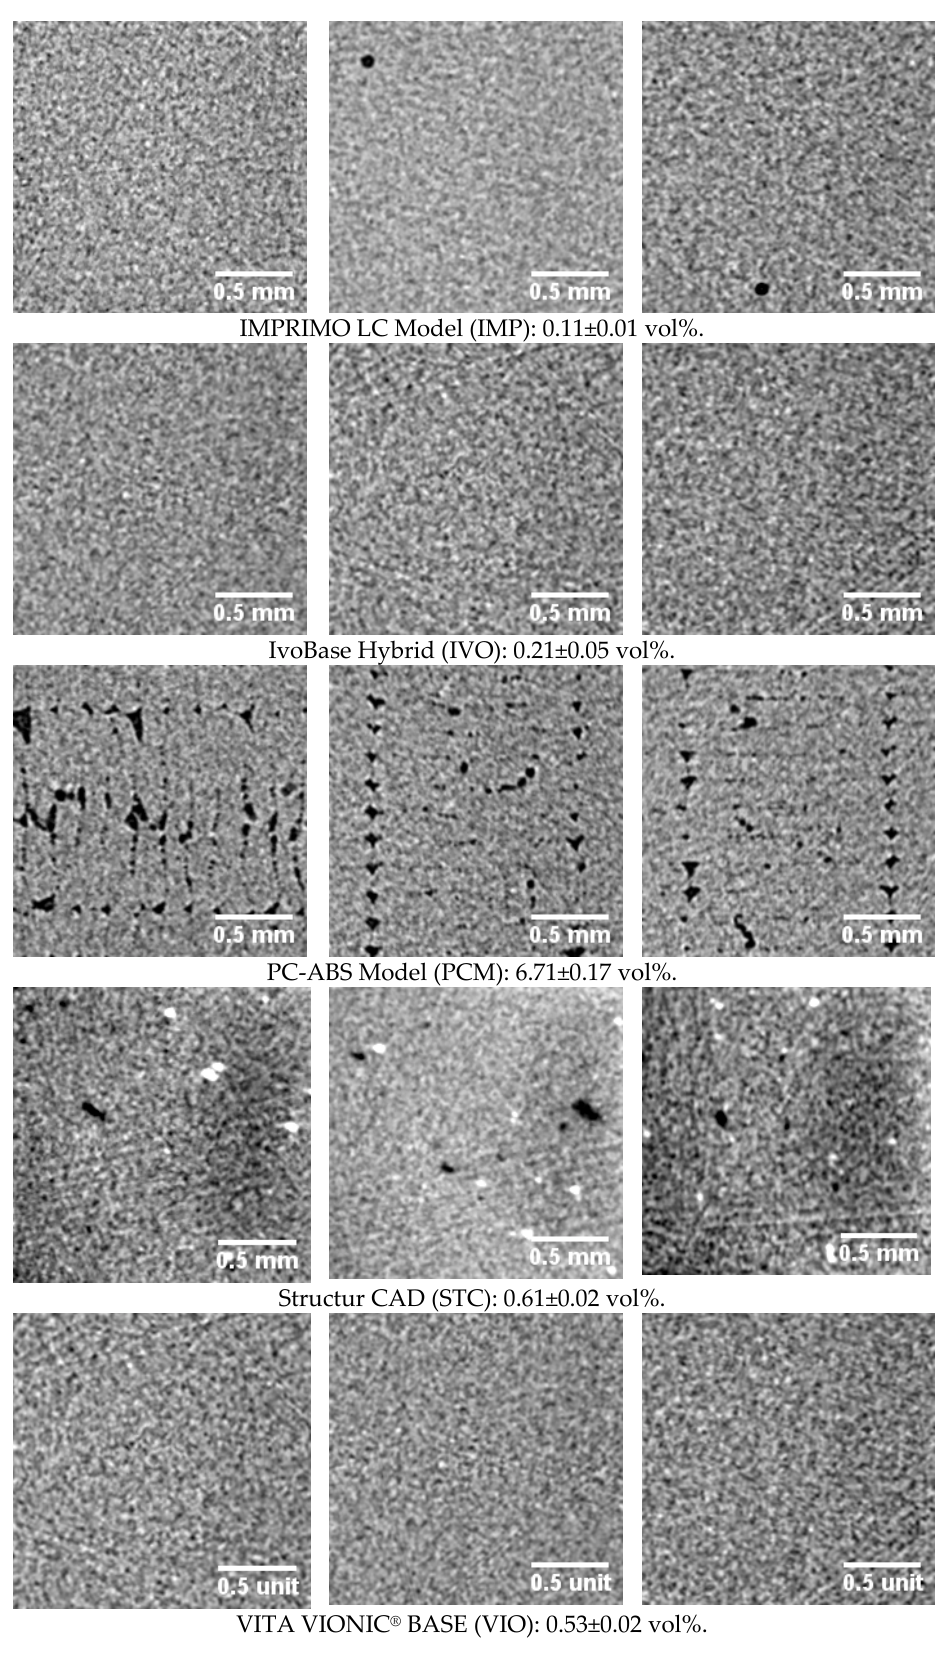
Figure 5. Cross sections (1.87 × 1.87 ≈ 3.50 mm 2 ) of three different prisms of each material with their Table 1. 87 × 1.87 × 11.45 mm 3